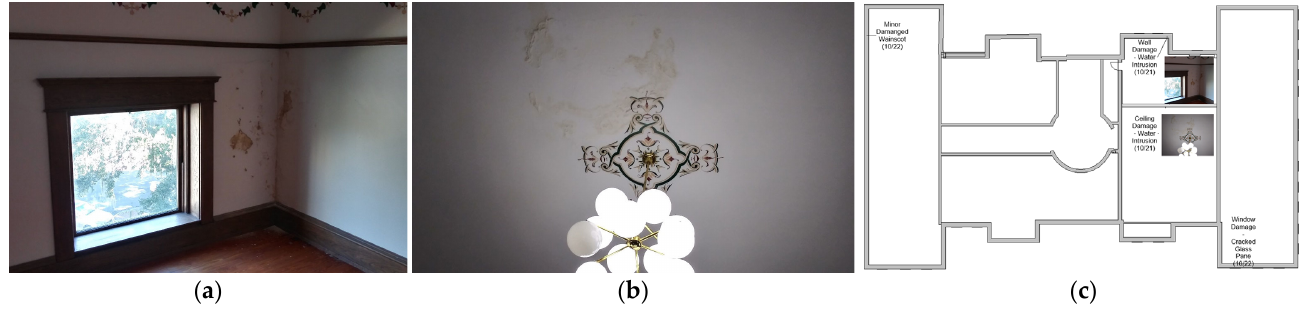
Figure 28. Demonstration of decay mapping using the HBIM “Complex Model”: ( a ) water damage to the courtoom balcony; ( b ) water damage to the courtoom plaster ceiling; ( c ) identification of damage using tags in Revit.